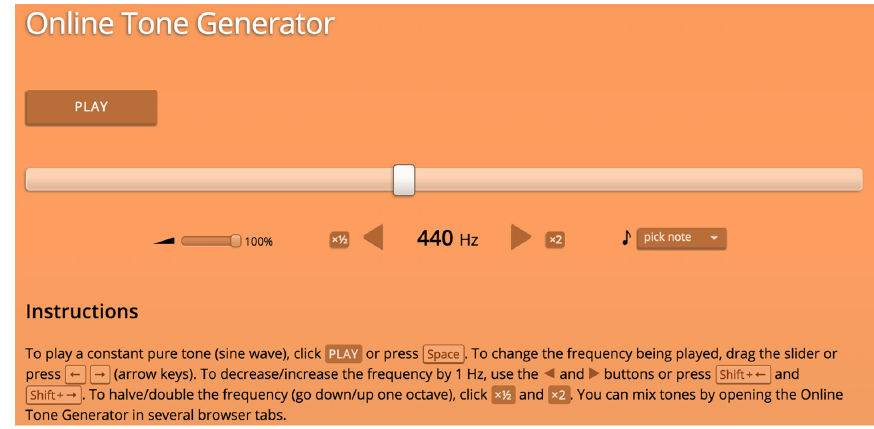
Figure 1. Graphic interface of the tone generator used in these experiments. When the interface first loads, the initial position of the controller is set at 440 Hz. The participants could then click and drag the mouse and sweep. The pitch of the tone increased as the controller was moved to the right, and decreased as the controller was moved leftward. If preferred, the participants also had the chance to choose specific notes by selecting the ‘pick note’ option. A fine ‐ volume control ( left ) and extra instructions ( bottom ) were also available.